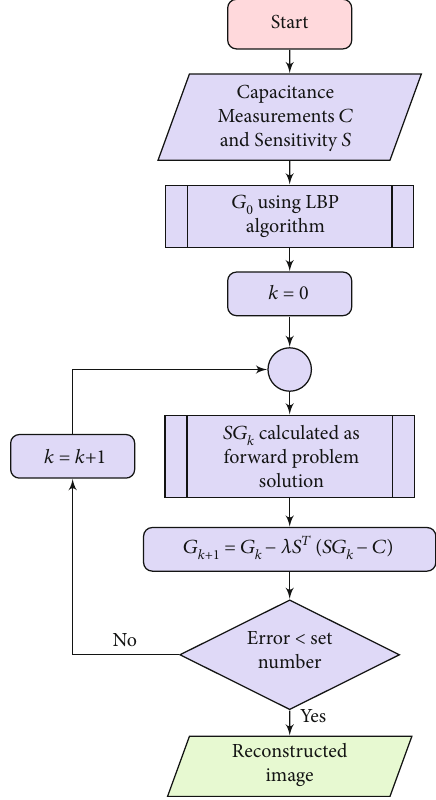
Figure 2: The iLBP image reconstruction algorithm in ECT.